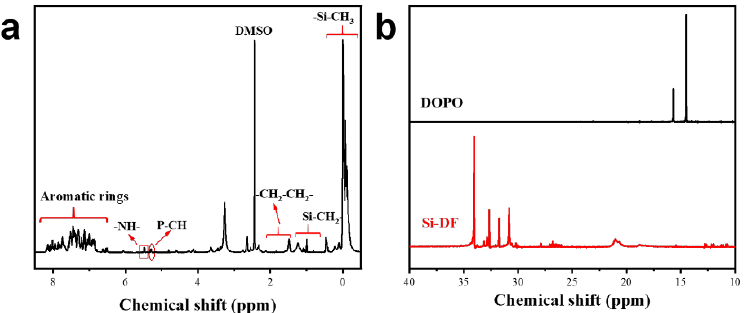
Figure 3. ( a ) 1 H NMR spectrum of Si-DF. ( b ) 31 P NMR spectra of Si-DF and